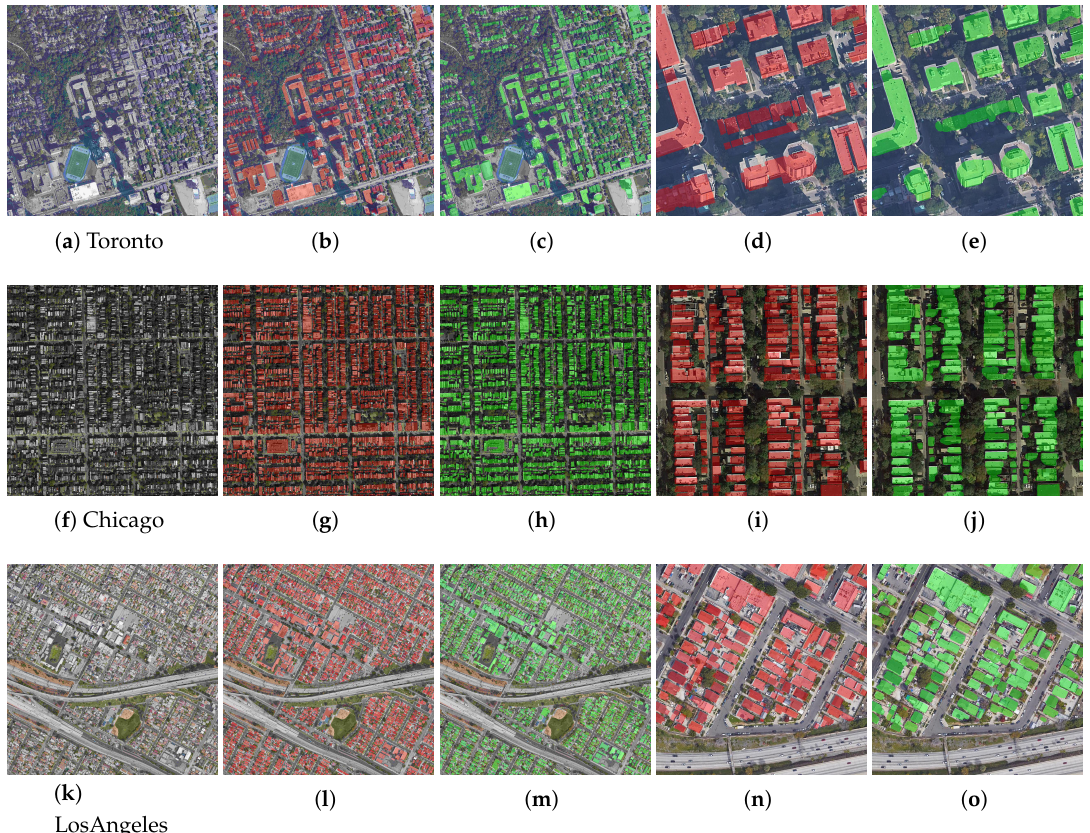
Figure 9. Samples from the cities of Toronto, Chicago, and Los Angeles in area B 1 . The figures of ( a , f , k ) are the sample images, and the figures of ( b , g , l ) colored in red are the ground truth of images. The figures of ( c , h , m ) colored in green are the prediction of GeoBoost. The figures of ( d , i , n ) are the center crop of labels, and the figures of ( e , j , o ) are the center crop of GeoBoost’s prediction. The first three columns are with a size of 4096 × 4096, and the last two is the center crop of the big images for observing details with a size of 1024 ×